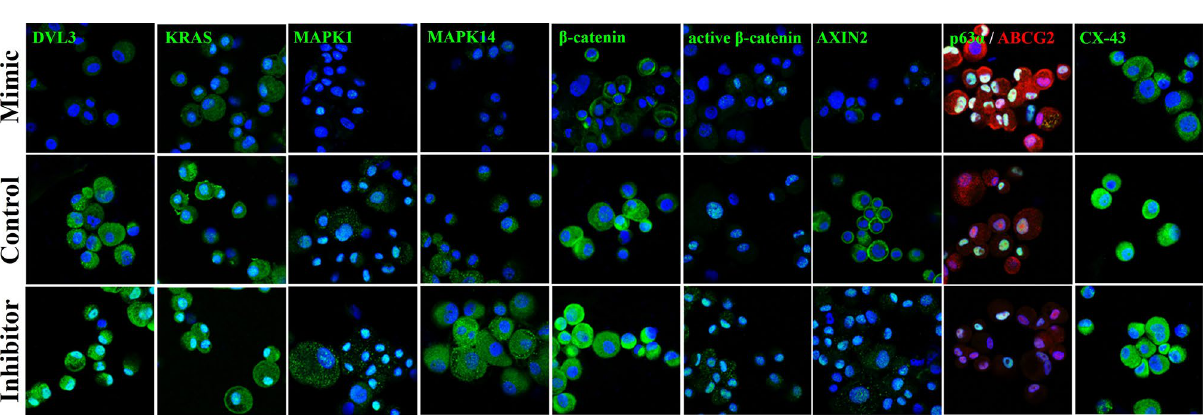
Figure 3. Localization of protein expression in hsa-miR-143-3p transfected cells. Representative confocal images of transfected limbal primary culture cells immunostained for DVL3, KRAS, MAPK1, MAPK14, β-catenin, Active β-catenin, AXIN2, ABCG2, p63 ⍺ and Cx43. Nuclei were stained with DAPI (Blue) and the protein expression with Alexa Fluor 555 (green) except for ABCG2 with Alexa Fluor 488 (red). Scale bar 50 µm. The detailed split channel images along with their relative fluorescent intensity are provided in Fig.